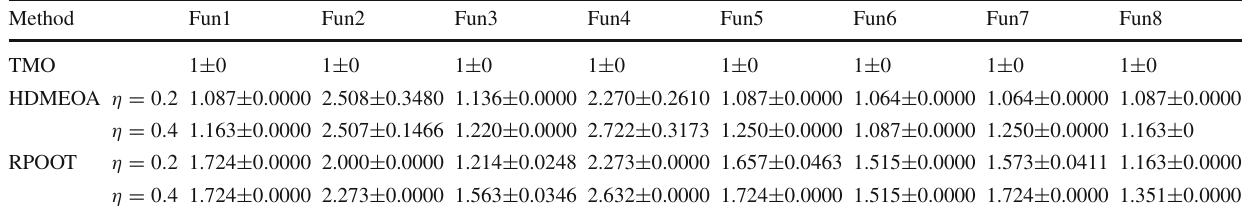
Table 4 MRST comparison of three methods under linear environmental changes Method Fun1 Fun2 Fun3 Fun4 Fun5 Fun6 Fun7 Fun8